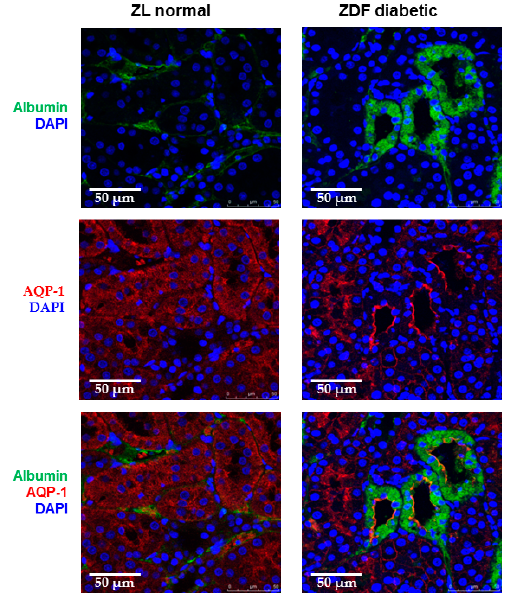
Figure 1. Albumin aggregation in proximal tubule epithelial cells of diabetic kidneys. Dual labeling using antibodies specific for rat albumin (green) and aquaporin-1 (AQP-1, red) reveals an accumulation of albumin in the AQP-1-positive tubules of 20-week-old Zucker diabetic fatty (ZDF) rats compared to Zucker lean (ZL) normal controls. Cell nuclei were stained by DAPI